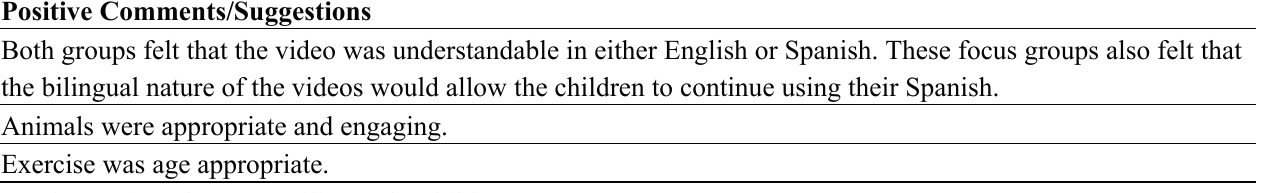
Table 2. Focus groups 2 demonstration video for teachers.